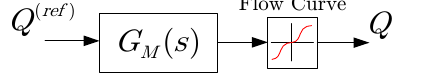
Figure 19: Comparison of simulated and measured valve flow at 0.3 Hz.